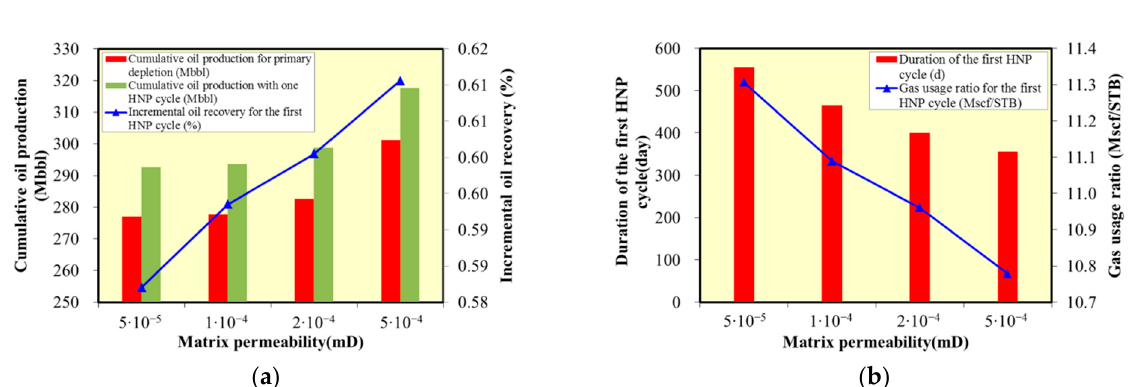
Figure 10. Effect of different matrix permeability with one huff-n-puff cycle on oil production and reservoir pressure: ( a ) Cumulative oil production for different matrix permeability; ( b ) Average reservoir pressure for different matrix permea- bility.